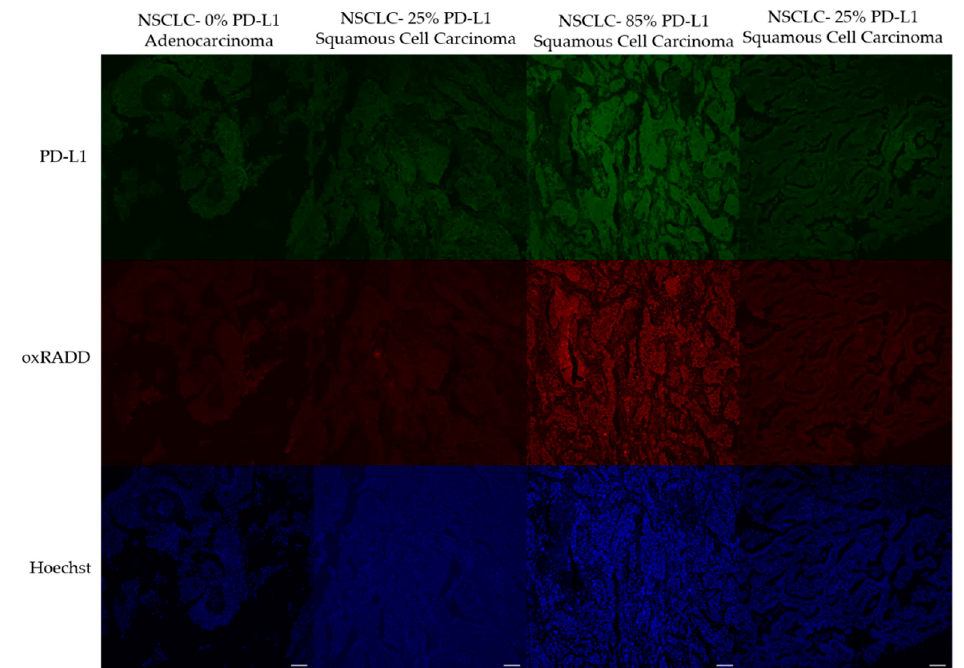
Figure 4. oxRADD and PD-L1 intensities in NSCLC tissues with known PD-L1 concentrations. Tumor core images from the control LC04 microarray. Scale bar = 100 µm.